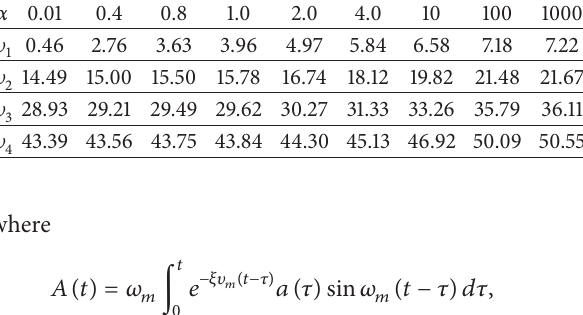
Figure 1: The influence of the damping coefficient on time response.